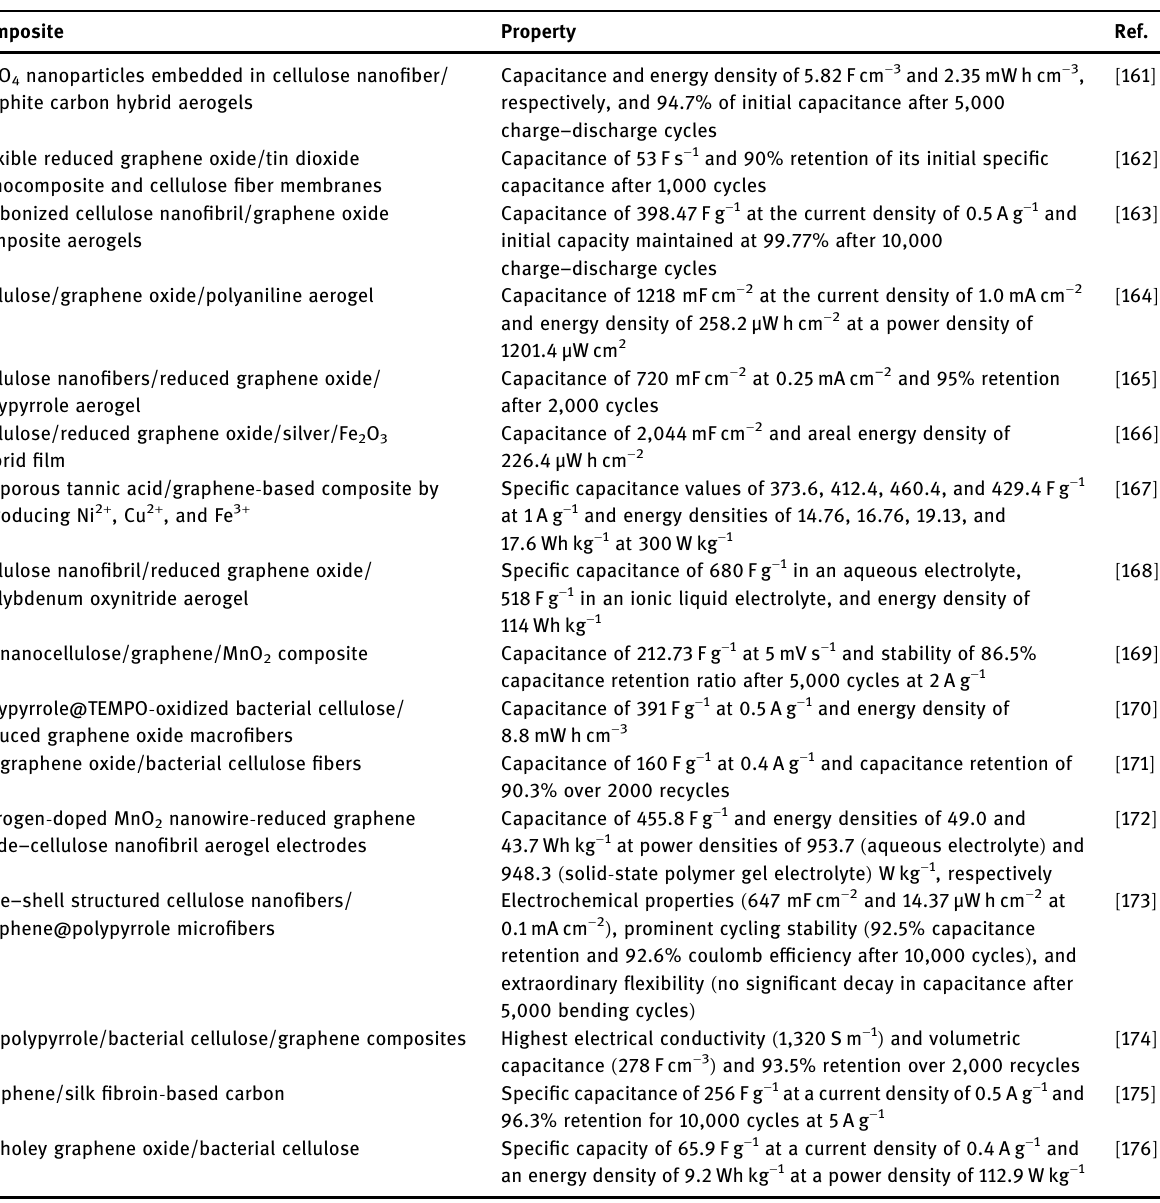
Table 2: Selected studies on biopolymer/graphene - based composites in supercapacitors Composite Property